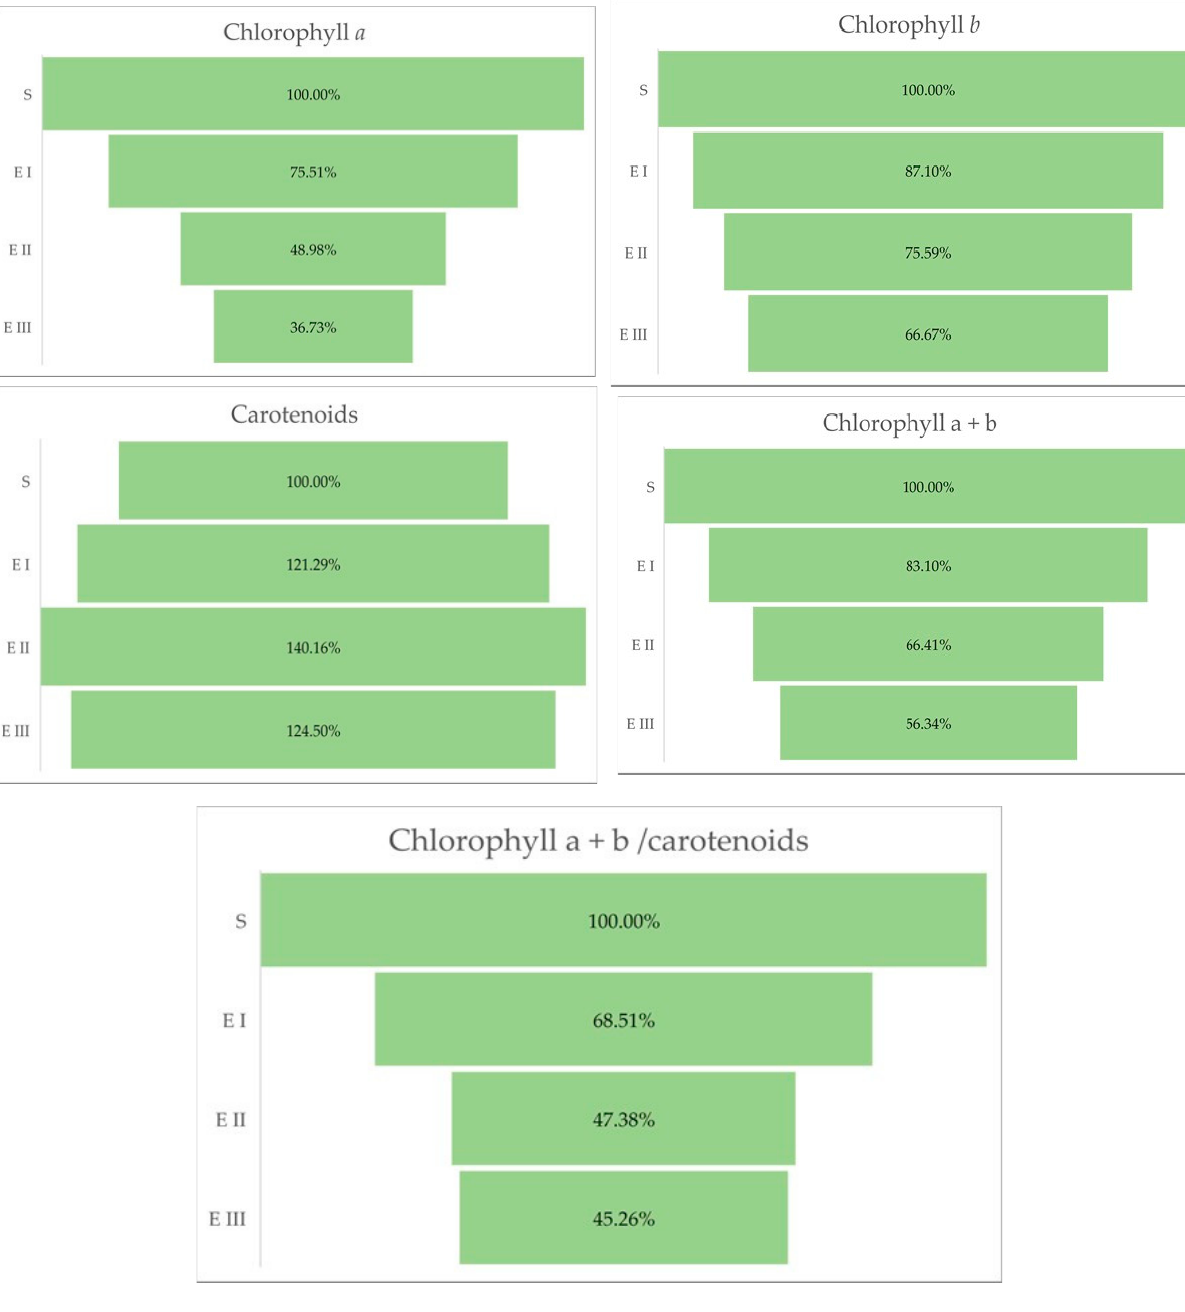
Table 4. PAL activity in different stages of the